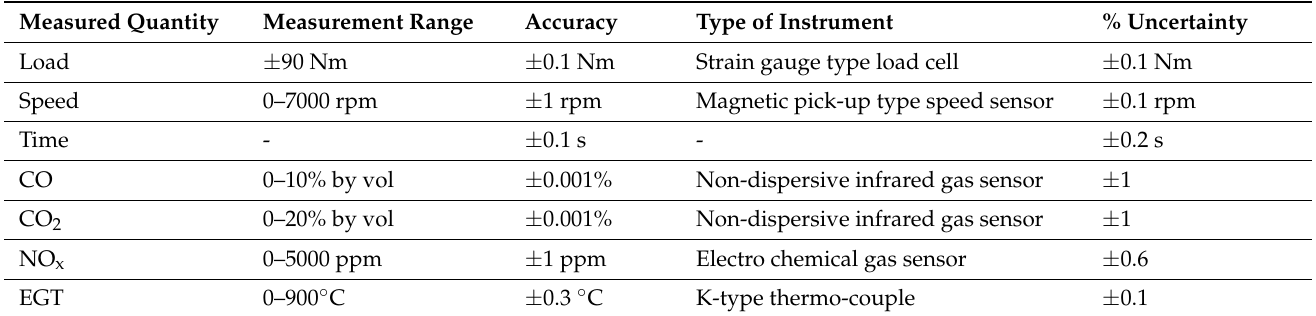
Table 1. List of instruments with measuring range, accuracy, and uncertainty